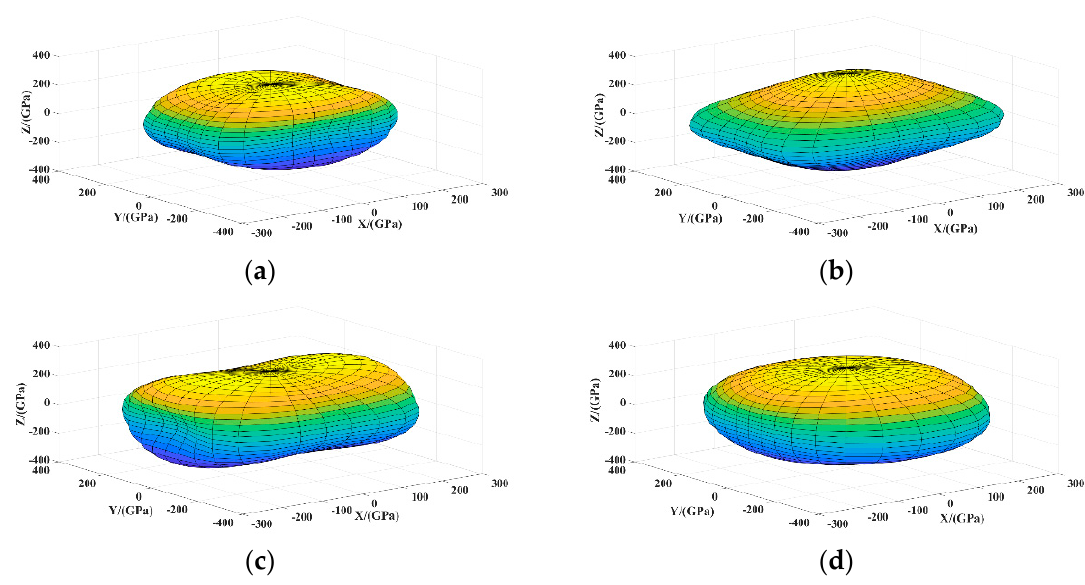
Figure 2. The surface construction of the Young’s modulus of Ni x B y compounds ( a ) Ni 3 B; ( b ) Ni 2 B; ( c ) Ni 4 B 3 ; ( d ) NiB.